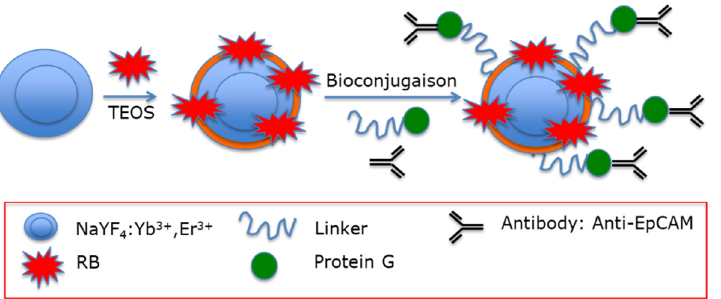
Figure 9. Covalent coupling of RB and antibody through a bifunctional fusion protein G. Adapted from Liang et al. [26].